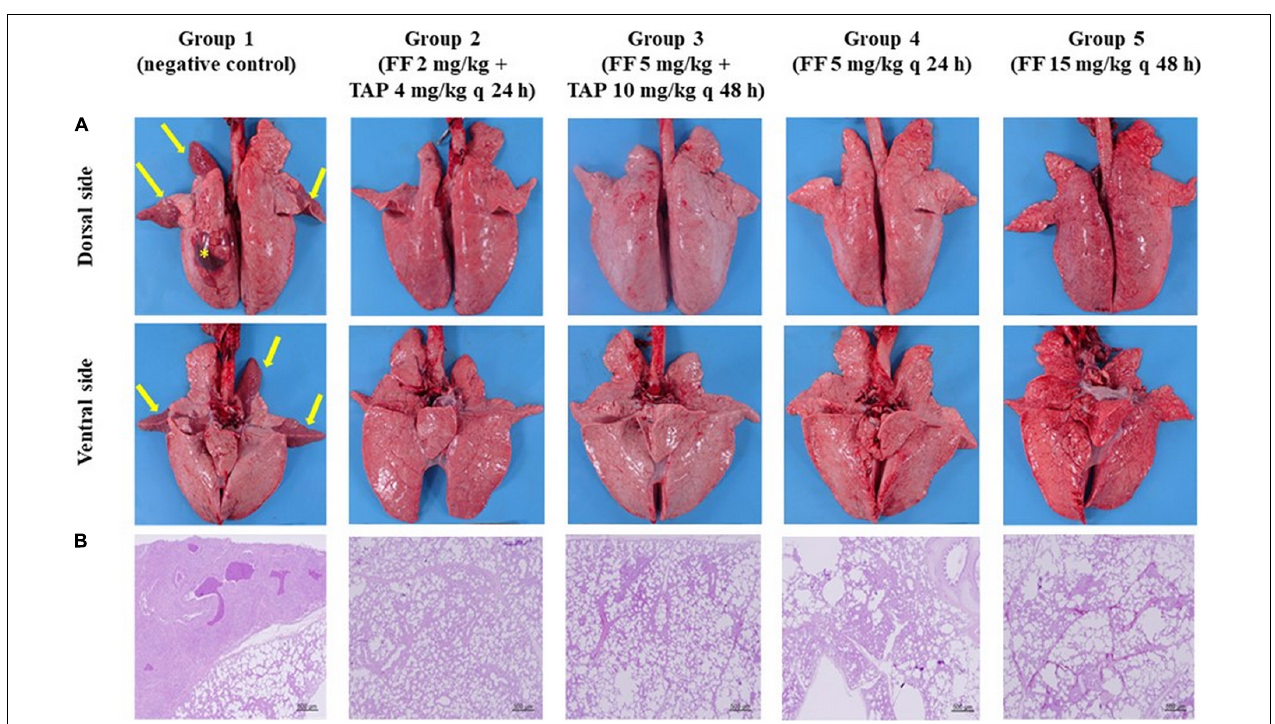
It is worth noting that the optimal ratios for drug combination dosages in vivo exhibited good proportionality to the optimal ratios with respect to in vitro MIC results. The MIC of FF could be reduced by up to 87.5% (1/8 MIC) for P. multocida when